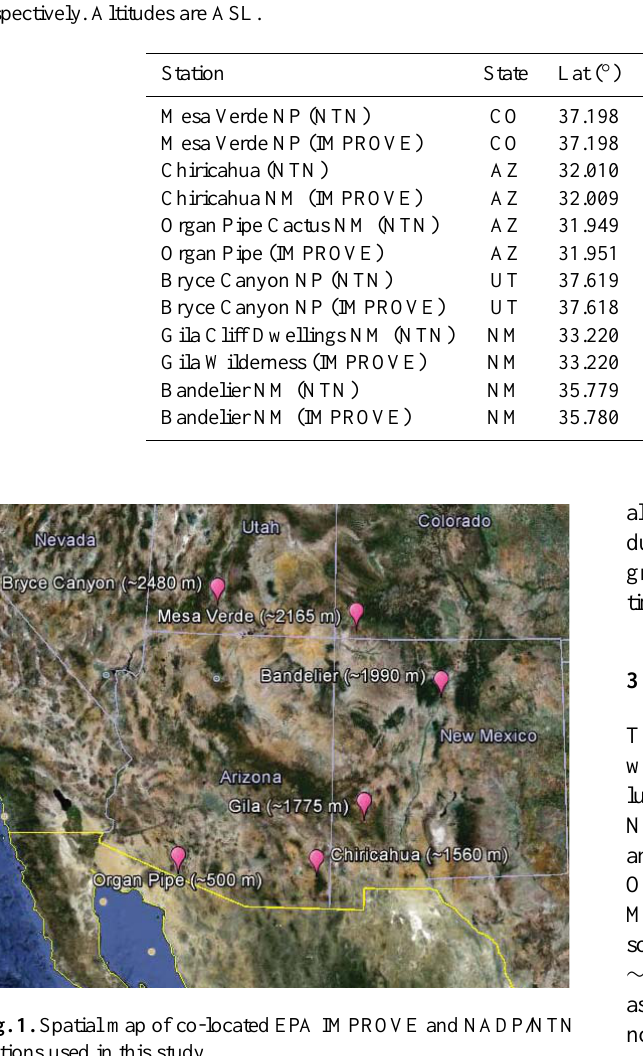
Table 1. Summary of co-located aerosol (IMPROVE) and precipitation (NADP/NTN) data used with coordinates, altitudes, and range of full years in which data are analyzed. The location of sites is shown in Fig. 1. “NP” and “NM” refer to National Park and National Monument, respectively. Altitudes are ASL.